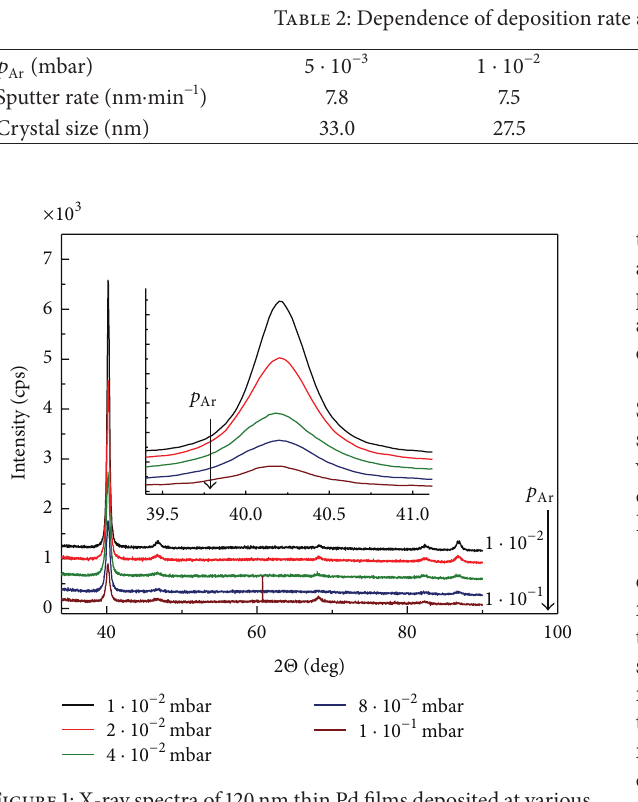
Figure 1: X-ray spectra of 120nm thin Pd films deposited at various sputtering